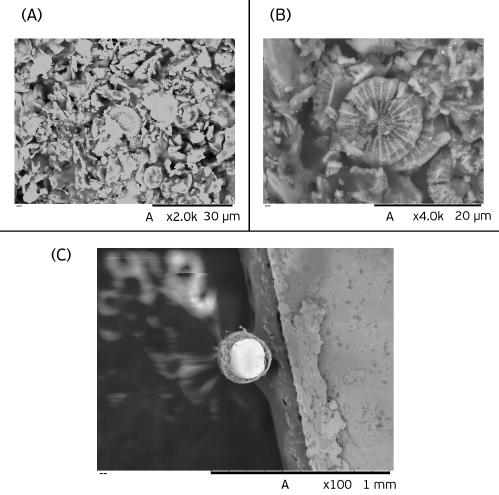
Figure 1. SEM micrographs obtained with the biosorbent fiber at magnifications of ( A ) 2000× and ( B ) 4000×, and a cross-section of the proposed fiber ( C ) at a magnification of 100×.